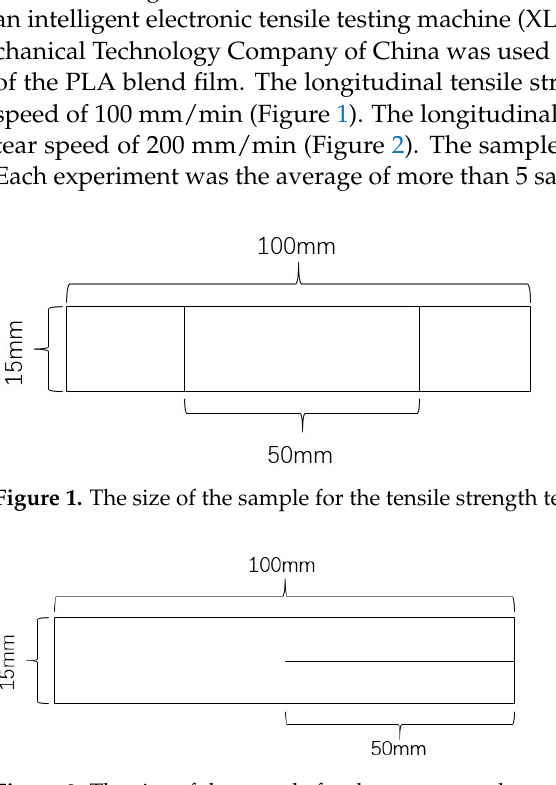
Figure 2. The size of the sample for the tear strength test.